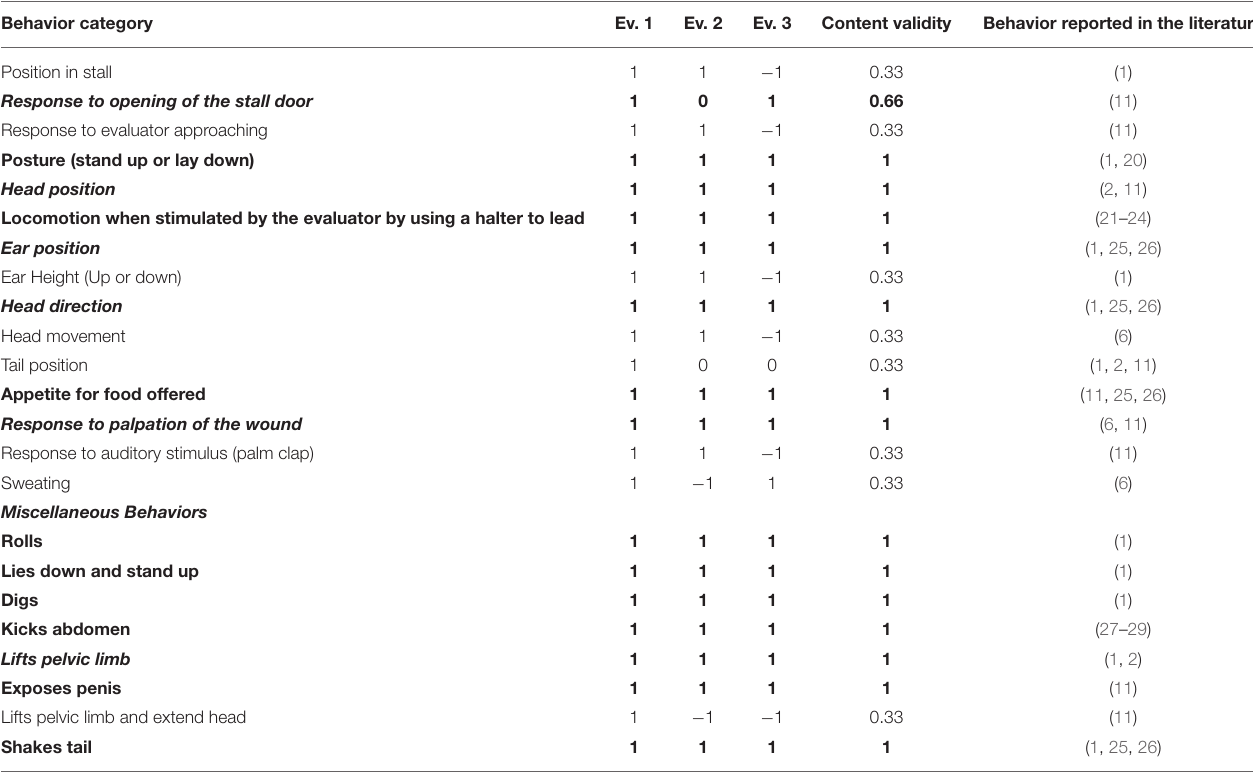
TABLE 1 | Criteria used to select the behaviors included in the donkey pain scale used for video analysis, based on content validity, and behaviors reported in the literature. Behavior category Ev. 1 Ev. 2 Ev.